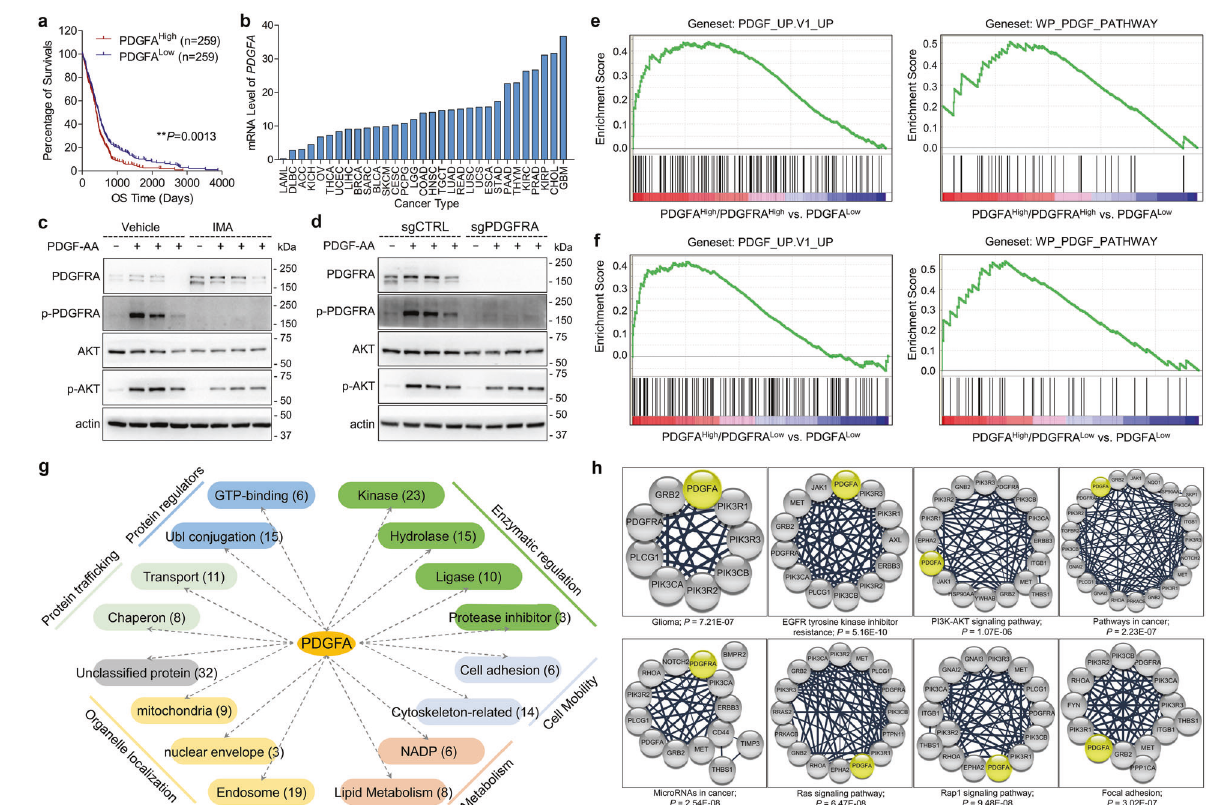
Fig. 1 PDGFRA is not necessary for PDGFA function in GBM cells. a Kaplan – Meier survival analysis of cases with PDGFA High vs . PDGFA Low from TCGA_GBM database. b PDGFA gene expression in TCGA PanCancer databases. c PDGFA-induced temporal expression of indicated proteins in LN18 cells pre-treated with vehicle or IMA. β -actin is used as loading control. d PDGFA-induced temporal expression of indicated proteins in LN18 cells transfected with control CRISPR/Cas9 or CRISPR/Cas9 targeting PDGFRA. e , f Enrichment of PDGF signaling-related genesets